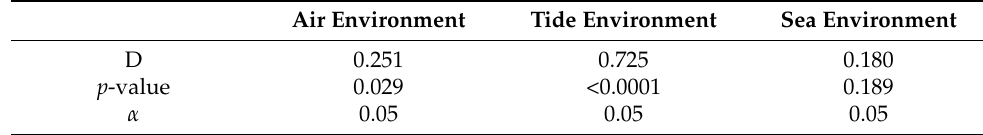
Table 17. Two-tailed KS test